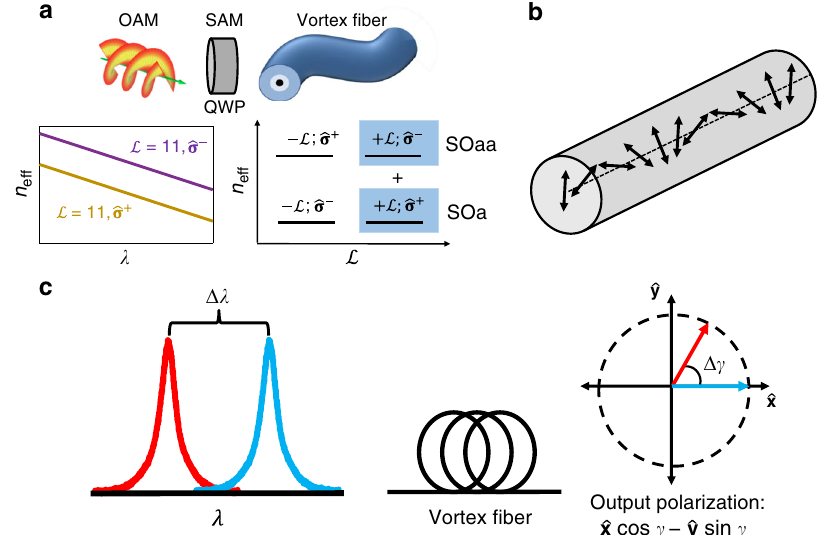
Fig. 1 Vortex fi ber superposition phenomena. a Spin orbit interaction (SOI) between OAM (image from E-Karimi is reproduced under a CC BY-SA license) and SAM (imparted by quarter wave plate, QWP) splits effective index ( n eff ) of SOa and SOaa states in a fi xed- j L j 4-D vortex fi ber mode Hilbert space. Numerical simulation reveals the circular birefringence between OAM L ¼ þ 11 modes with opposite b σ . The superposition of the highlighted blue states is a linearly polarized OAM beam; which, when launched into the vortex fi ber (reproduced from ref. 13 , 2015, Optical Society of America), experiences optical activity. b Illustrative depiction of optical activity, where a linearly polarized beam rotates while propagating through the vortex fi ber. c The wavelength dependence of optical activity, known as optical rotary dispersion, means a shift in wavelength ( Δ λ ) rotates the output linear polarization ( Δ γ